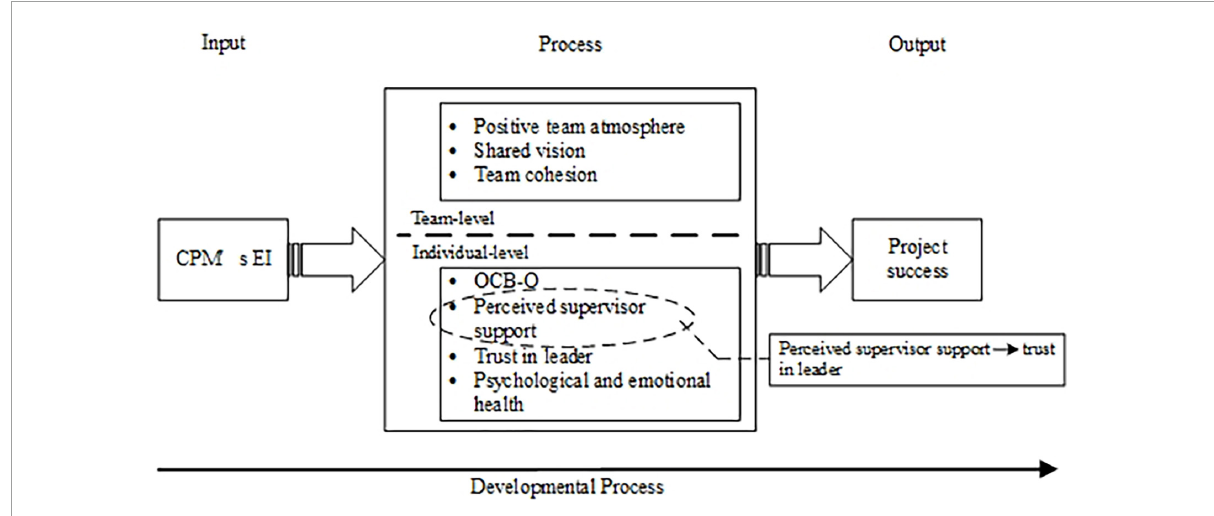
FIGURE2 A mechanism of construction project manager’s (CPM’s) emotional intelligence (EI) on project success.